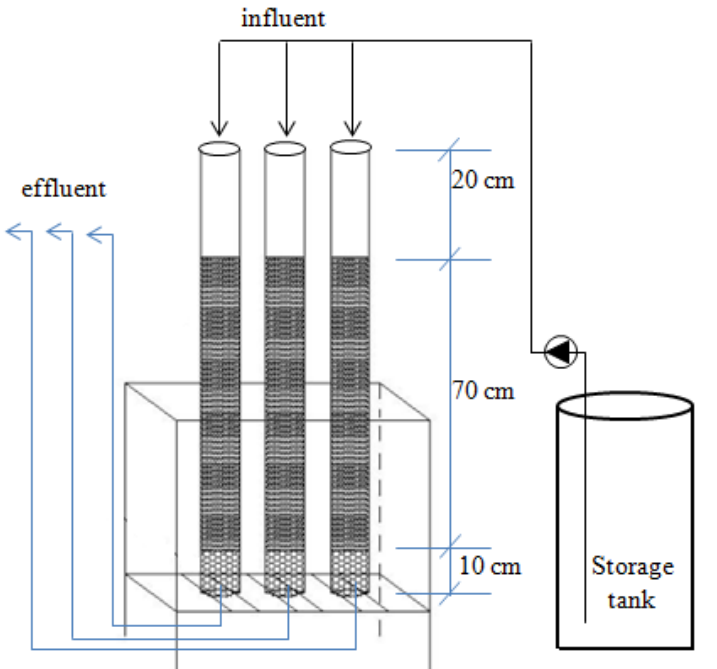
Figure 2. Schematic flow chart of filter column.